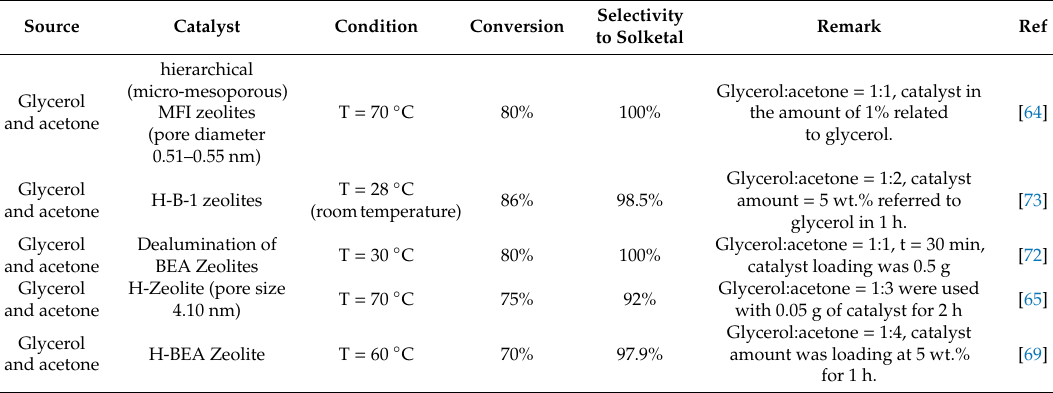
Table 6. Glycerol-to-solketal over hierarchical zeolite